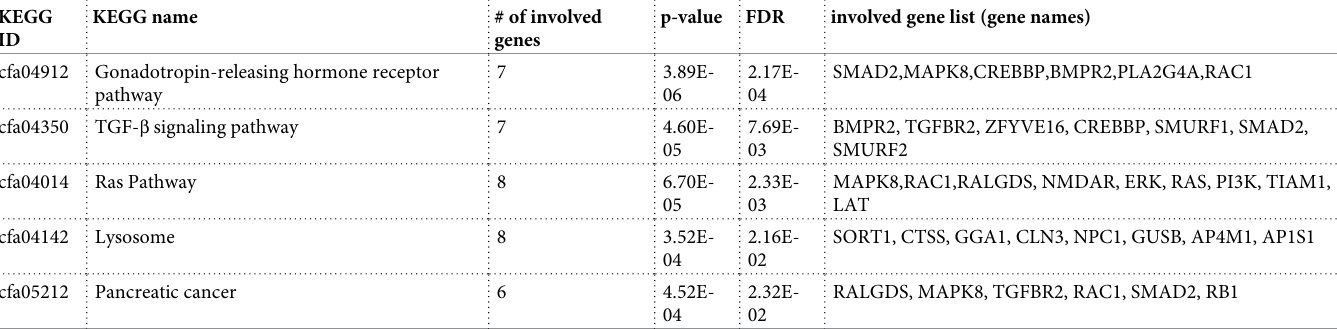
Table 2. Significantly enriched KEGG pathways in hypermethylated/upregulated genes in gene body regions in CLBL-1 8.0. KEGG